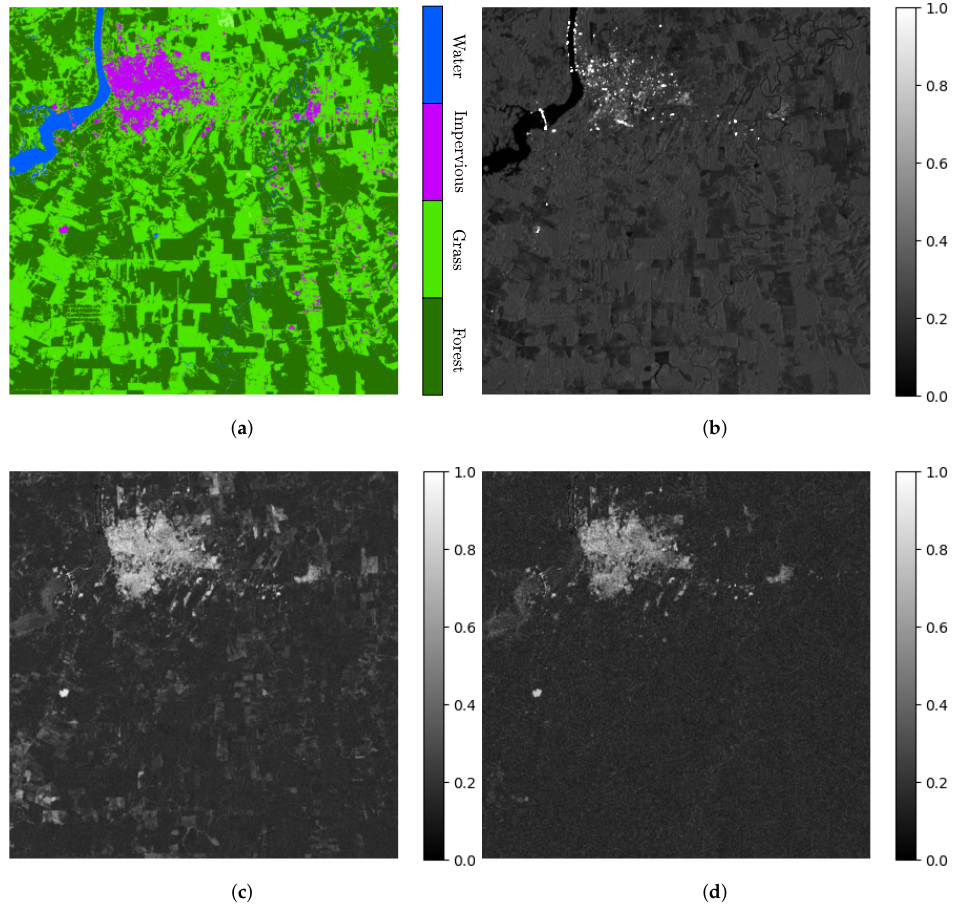
Figure 12. Metropolitan area of Porto Velho, capital of the state of Rondônia, shown according to: ( a ) the FROM-GLC thematic map, ( b ) average SAR backscatter, ( c ) 6 d coherence, and ( d ) 24 d coherence. In this case, the long-term coherence is more suitable for the detection of impervious (e.g., urban)